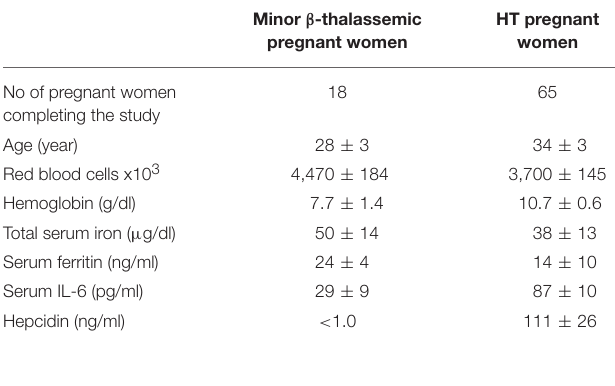
TABLE 1 | Demographics and baseline of hematological mean values ± SD of minor β -thalassemic and HT pregnant women affected by anemia and AI, respectively, enrolled between the 6th and 8th week of gestation.